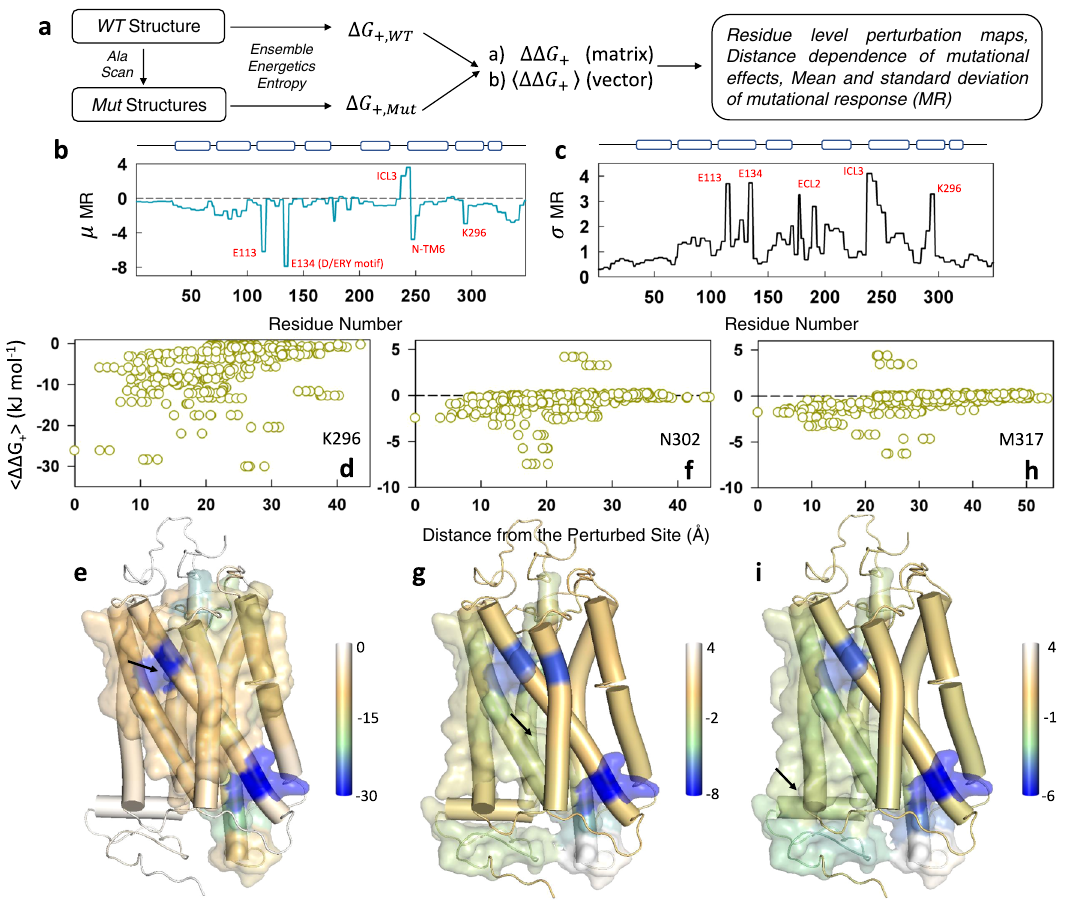
Fig. 7 | Alanine-scanning reveals long-range communication in Rhodopsin. a Protocol employed for in silico alanine-scanning mutagenesis studies from the perspective of the WSME model. b , c Mean ( b ) and standard deviation ( c ) of the mutational response (MR in kJmol − 1 ). Speci fi c residues and structural regions are highlightedfordiscussioninthemaintext.E113andK296areintheretinalbinding pocket while E134 forms a part of the conserved D(E)RY motif that interacts with the G-protein. N-TM6 represents the N-terminal region of TM6. d , e Perturbation